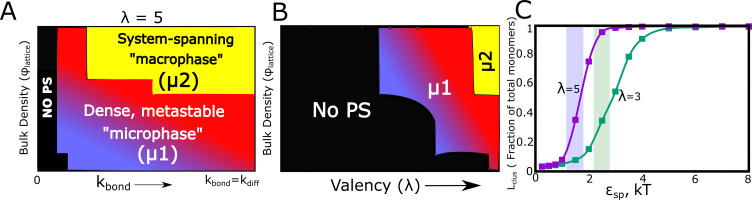
Kinetic Monte Carlo Simulations.(A) Phase diagram highlighting the different phases (metastable microphase (μ1) or system-spanning macrophase (μ2), and the non-phase separated state (No PS) ) encountered upon increasing kb⁢o⁢n⁢d(between 0 and kd⁢i⁢f⁢f ), and the bulk density of monomers (ϕl⁢a⁢t⁢t⁢i⁢c⁢e ) within the box. The assembling particles have a valency (λ) of 5 in these simulations. The region shaded yellow represents part of the phase-space where we observe a system-spanning network whereas the bluish-red region represents the metastable micro-phase with a distribution of cluster sizes (see Figure 7—figure supplement 3 for distributions). As we move from the blue to the red regions in this dynamic phase diagram, the size of the single largest cluster increases (also see Figure 7—figure supplement 1). (B) Phase diagram highlighting the different phases encountered upon varying valency and bulk density as the phase parameters. The system-spanning macrophase is only encountered for larger valency particles at higher densities. This phase diagram was computed for kb⁢o⁢n⁢d=kd⁢i⁢f⁢f and ϵn⁢s of 0.35 kT. (C) The fraction of monomers in the largest cluster as a function of epsilon, for kd⁢i⁢f⁢f = kb⁢o⁢n⁢d and ϕl⁢a⁢t⁢t⁢i⁢c⁢e = 0.04. The single largest cluster sizes in all sub-panels of this Figure were computed for a simulation time-scale of 2 hr (with the fundamental timsecale of diffusion being set to kd⁢i⁢f⁢f = 1 s-1 ).
Figure 7—source data 1.Compressed zip file containing the source data for kinetic phase diagrams in Figure 7.